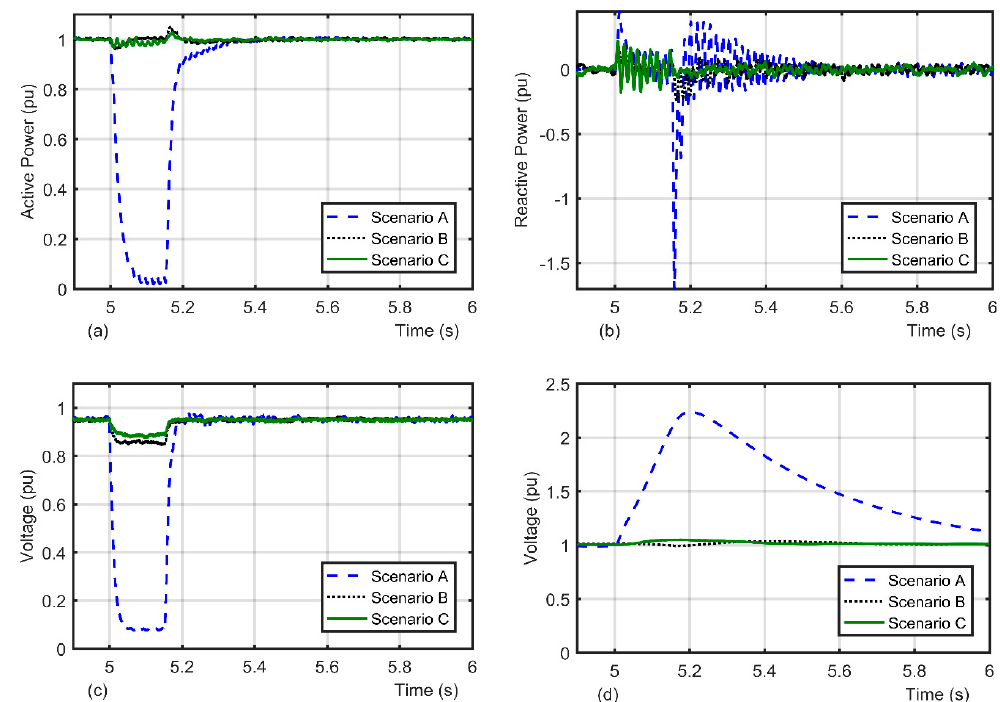
Figure 7. Severe voltage sag conditions, ( a ) Active power, ( b ) Reactive power, ( c ) Terminal voltage, ( d ) DC link voltage.